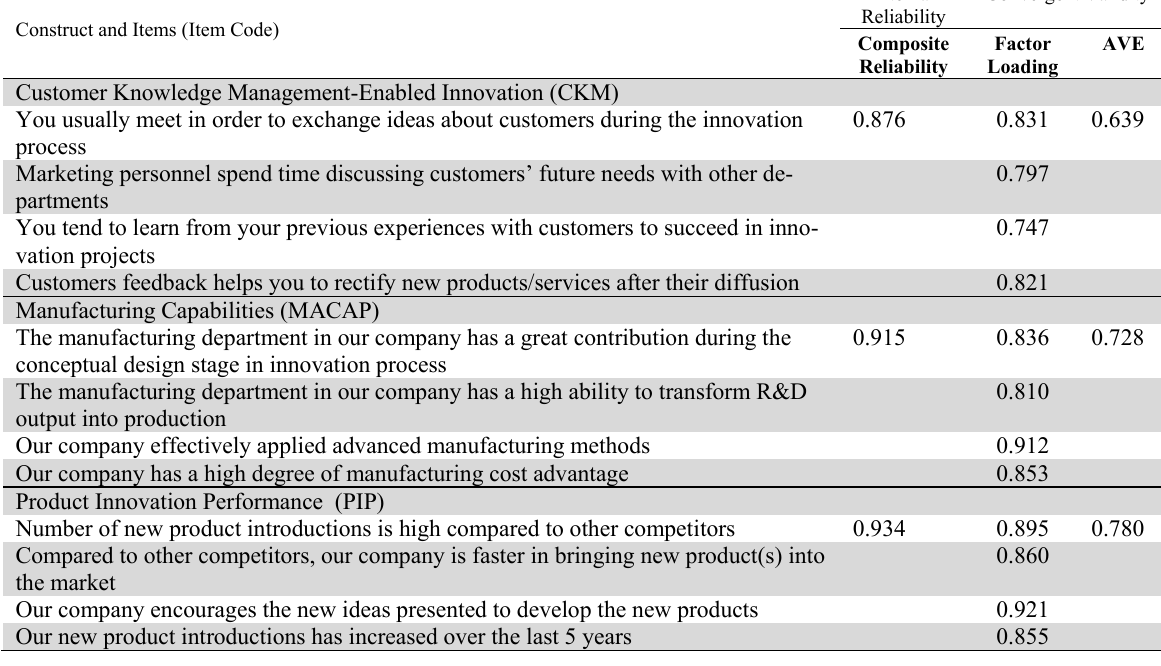
The reliability and validity of constructs